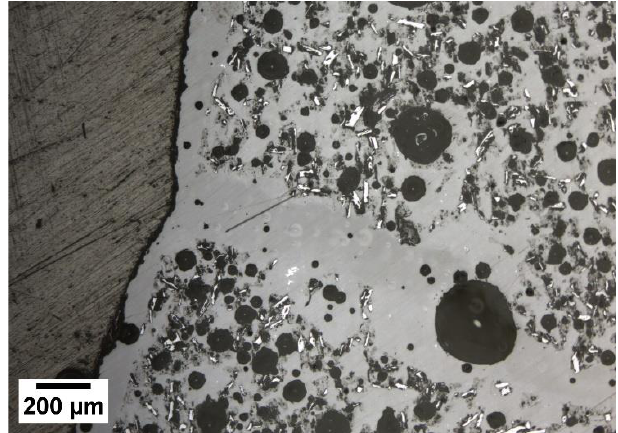
Figure 4. Micrograph of polished ASH-G composites after heating to 900 °C for 5 h using heat- ing/cooling rates of 2.5 °C/min.